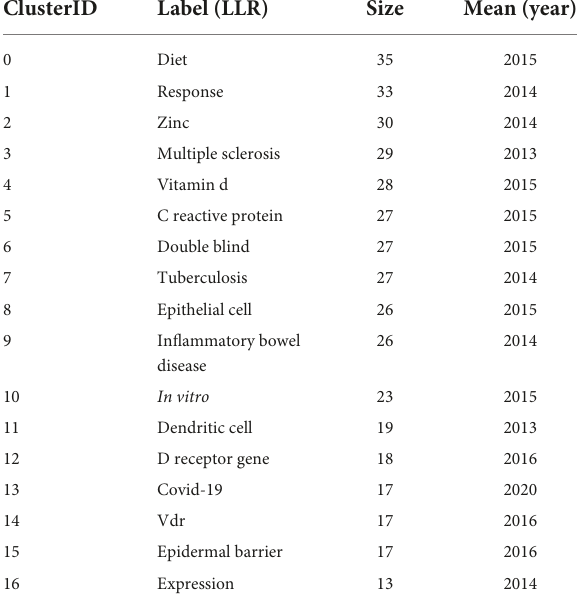
TABLE 3 Cluster summary